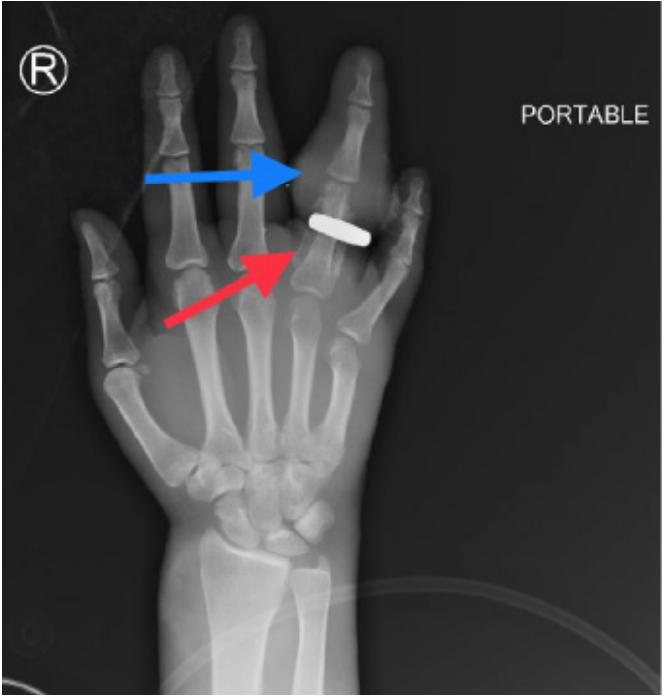
Image 1. Radiograph of right hand with marked fourth digit swelling distal to the patient’s ring suspicious for tourniquet syndrome. The blue arrow shows soft tissue swelling and the red arrow shows periosteal elevation. Periosteal reaction involving proximal fourth digit phalanges suspicious for osteomyelitis (both arrows).